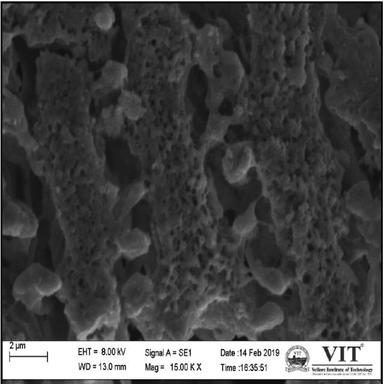
SEM image of unburnt highly porous SCBA particle.